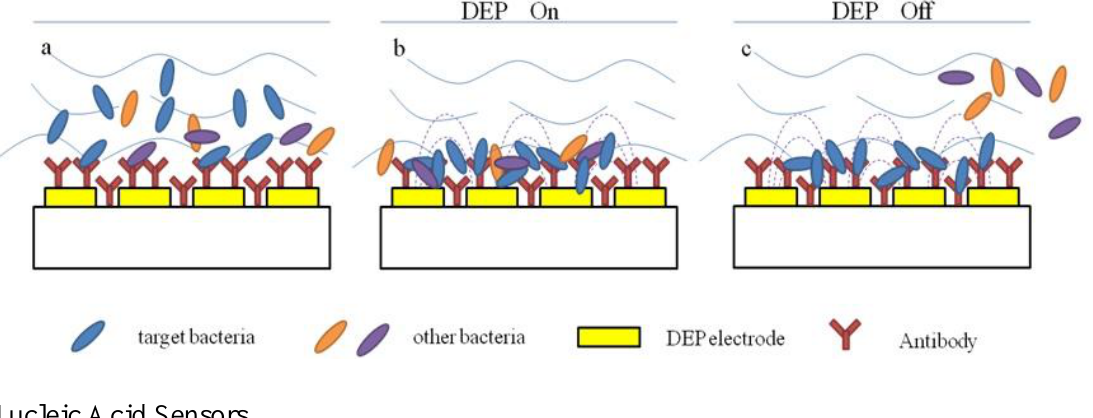
Figure 3. Principle of impedance coupled with dielectrophoresis and